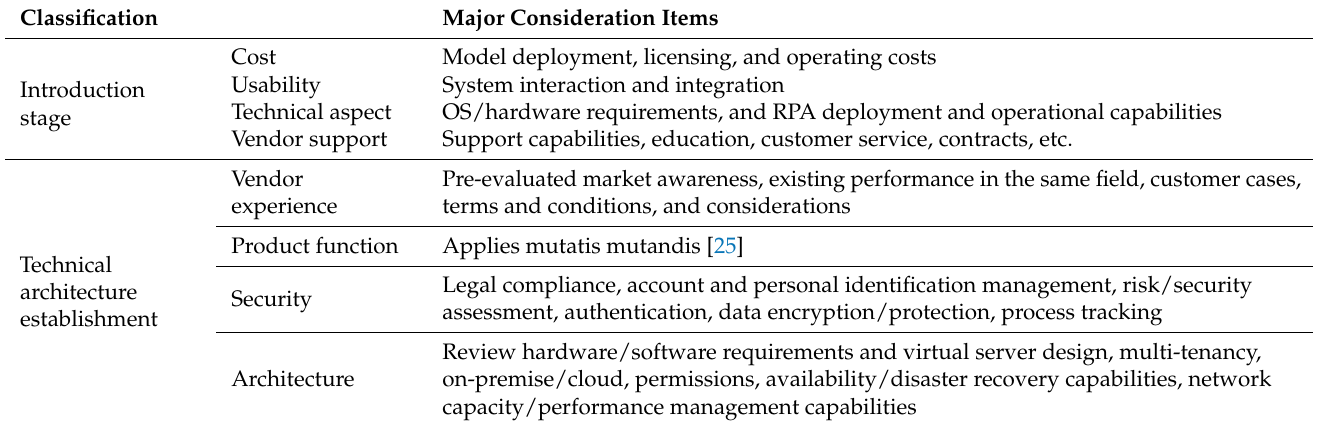
Table 2. Key considerations for RPA evaluation according to Korea’s SPRI. Adaptation based on Ref.